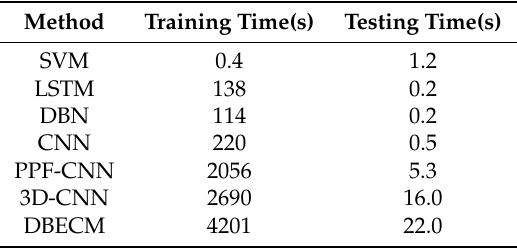
Table 7. Seven algorithms under the Indian pines dataset schedule.